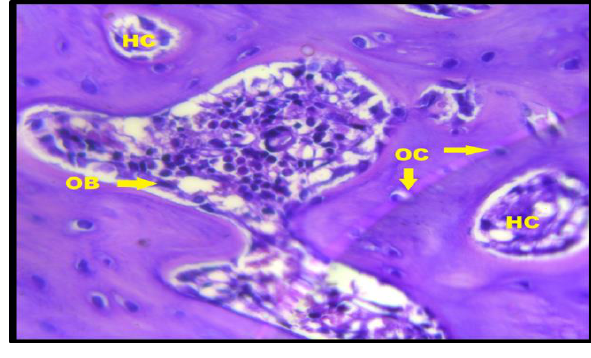
Figure (2): Control group at 4-weeks showing osteoblasts (OB) lined Haversian canal and osteocytes (OC) filled